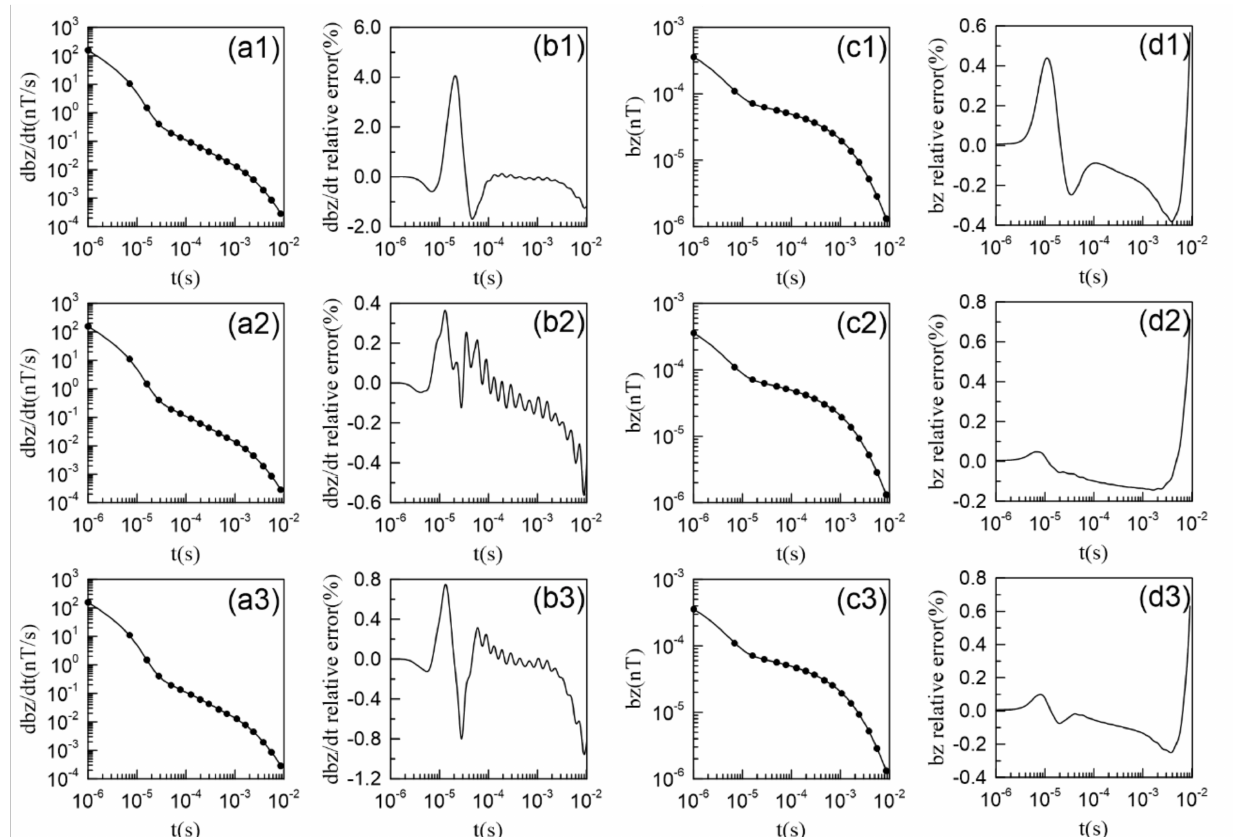
Figure 3. dbz/dt and bz responses and relative errors against the semi-analytical solutions for the combinations of different mesh size and the orders of the interpolation functions. ( a1 )–( d1 ) third order of interpolation functions combined with the mesh size of 20 m × 20 m × 20 m; ( a2 )–( d2 ) third order of interpolation functions combined with the mesh size of 20 m × 20 m × 10 m; ( a3 )–( d3 ) fourth order of interpolation functions combined with the mesh size of 20 m × 20 m × 20 m. Note that the modeling accuracy can be improved by either refining the mesh or increasing the order of the interpola- tion